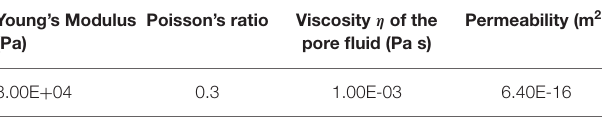
TABLE 1 | The material properties specified for the simulated poroelastic sample. Young’s Modulus (Pa)